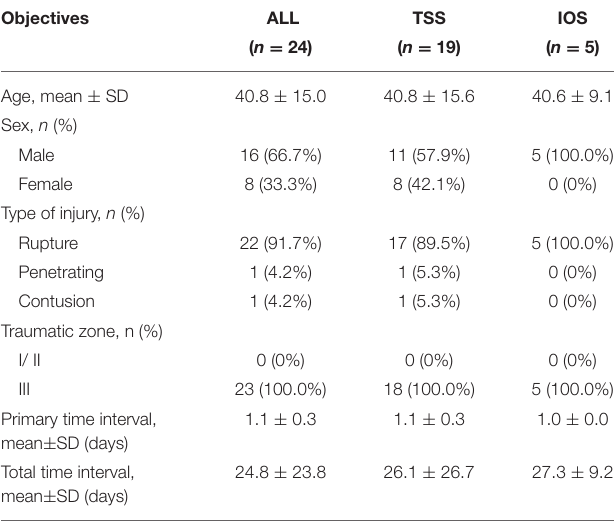
TABLE 1 | Basic characteristics of enrolled subjects. Objectives